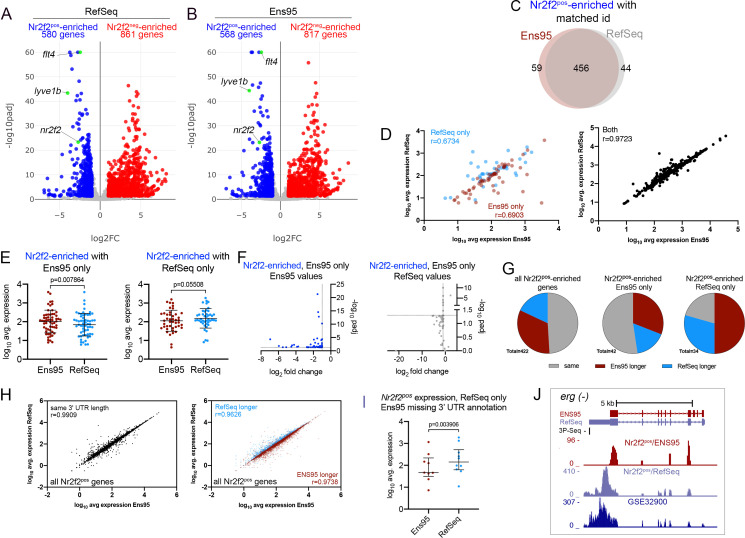
Analysis of RNA-seq reads from a random-primed library.(A,B) Volcano plots of differentially expressed genes from Nr2f2-positive and -negative (Nr2f2pos and Nr2f2neg) endothelial cells identified using RNA-seq reads quantified with (A) RefSeq or (B) Ensembl, version 95 (Ens95) transcript annotations. Genes with significant enrichment (padj <0.05) are shown as red or blue (log2 fold change >1 or <-1, respectively). Grey dots are genes that fall below statistical cutoffs. (A, B) Green dots are selected known vein-specific genes. (C) Venn diagram of genes with a common NCBI ID in Ens95 and RefSeq identified as significantly Nr2f2pos-enriched using either annotation. (D) Correlation of log10 average expression levels (n = 3) from indicated annotation for Nr2f2pos-enriched genes identified selectively as such by Ens95 or RefSeq only (left plot) or both annotations (right plot). Data are not normally distributed, Spearman correlation, r values are indicated. (E) Log10 average expression (n = 3) for Nr2f2pos-enriched genes as quantified by each indicated annotation. Separate plots shown for genes selectively identified as Nr2f2pos-enriched using Ens95 or RefSeq. Data are not normally distributed, Wilcoxon matched-pairs signed-rank test, p values are indicated. (F) Plots of commonly annotated genes identified as Nr2f2pos-enriched only by Ens95 with indicated values from Ens95 (left plot) or RefSeq (right plot). (G) Pie charts showing the proportion of reference genes identified as Nr2f2pos-enriched by Ens95 and RefSeq with indicated relative 3' UTR length. (H) Correlation of log10 average expression from Nr2f2pos RNA-seq (n = 3) quantified with each annotation for matched reference genes with same 3' UTR length or longer Ens95 or RefSeq 3' UTR length. Data are not normally distributed, Spearman correlation, r values are indicated. (I) Log10 average expression (n = 3) as quantified by Ens95 or RefSeq for Nr2f2pos-enriched genes lacking an Ens95 3' UTR annotation. Data are not normally distributed, Wilcoxon matched-pairs signed-rank test, p value is indicated. (J) UCSC browser image of the erg gene (on minus strand) showing 3' UTR annotation and lack thereof from RefSeq and Ens95, respectively. Mapped depth of RNA-seq reads from Nr2f2pos cells captured for each annotation is indicated. Genome-mapped consolidated reads from GSE32900 are also shown as is the location of 3P-seq feature, also on the minus strand.